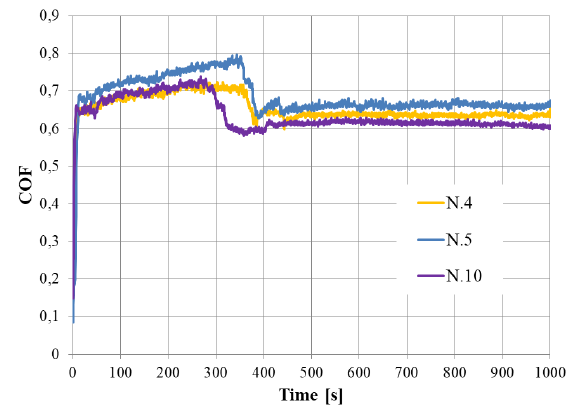
Figure 3. Comparison of COF progress of Ball-on- Flat tested specimens. Note: for illustration only one track for every specimen is